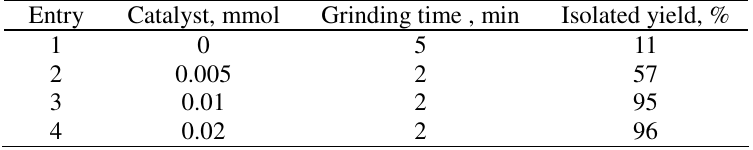
Table 1. The effect of amount of silicotungstic acid on the yield of 3a by grinding.* Entry Catalyst, mmol Grinding time , min